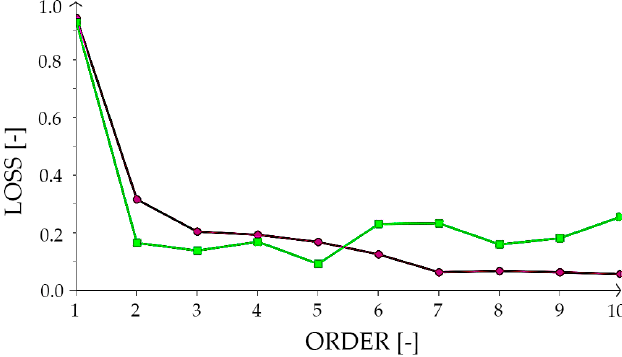
Figure 5. Incremental order algorithm performance. The chart presents a loss history, where the purple line is the training loss and the green one is the selection loss. The vertical axis is a loss and the horizontal axis is an